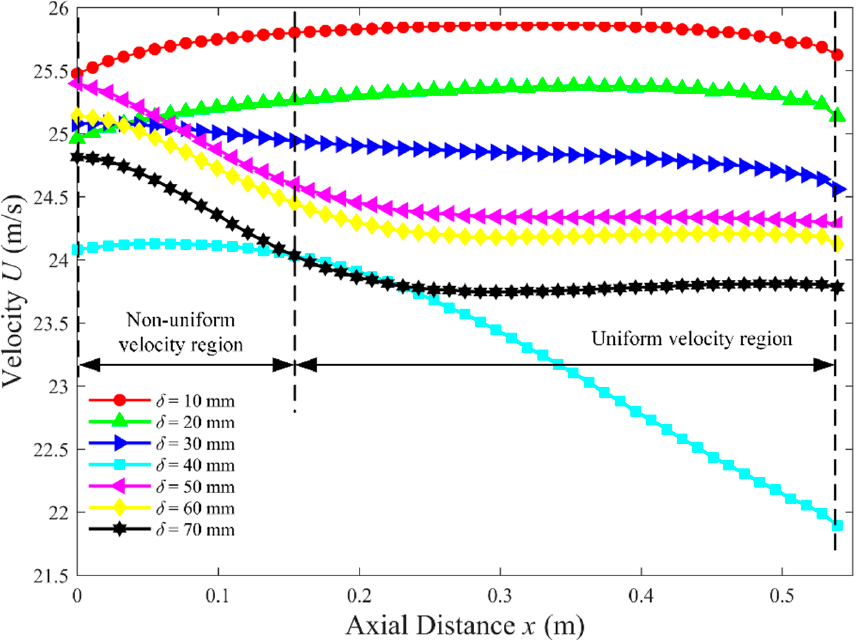
Figure 10. Variation of velocity distribution characteristics with axial distance under different honeycomb thicknesses.